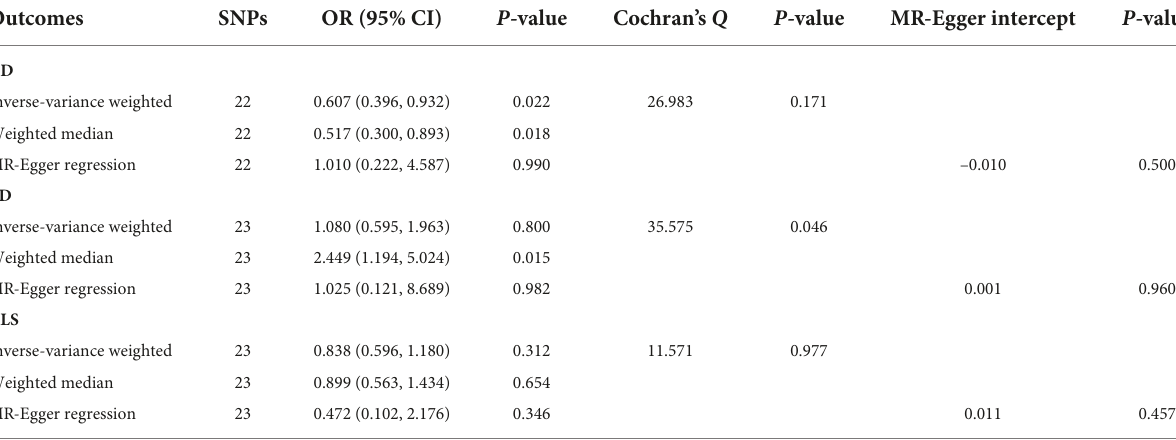
TABLE 3 Mendelian randomization analyses of circulating serotonin levels on three neurodegenerative